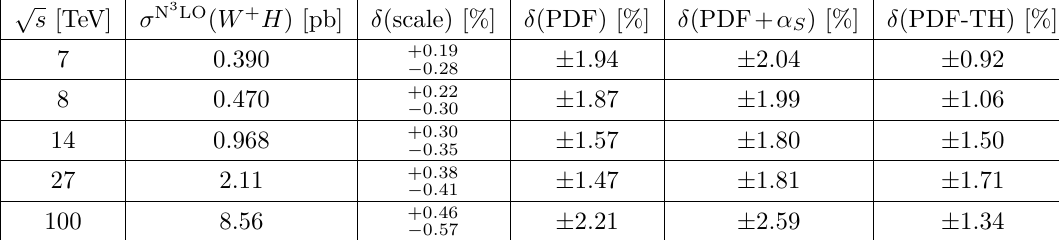
Table 10 . The same as in table 7, but with µ 0 = M H + M W .